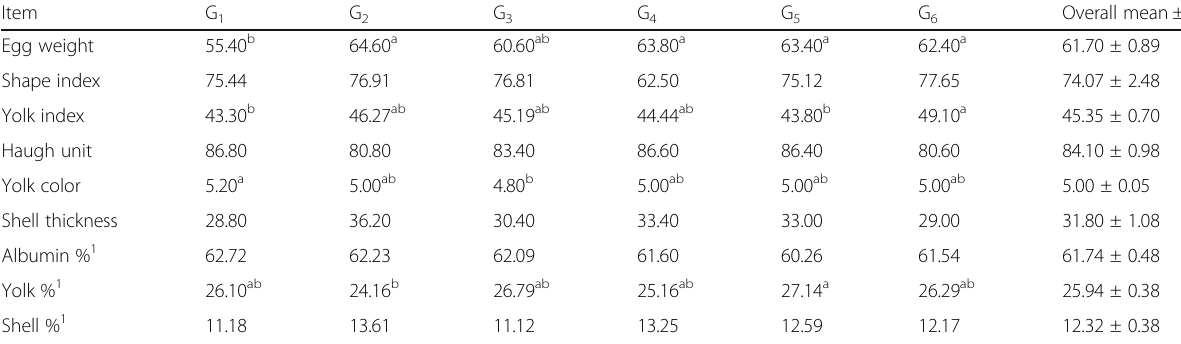
Table 4 Effect of dietary treatments on egg quality of laying